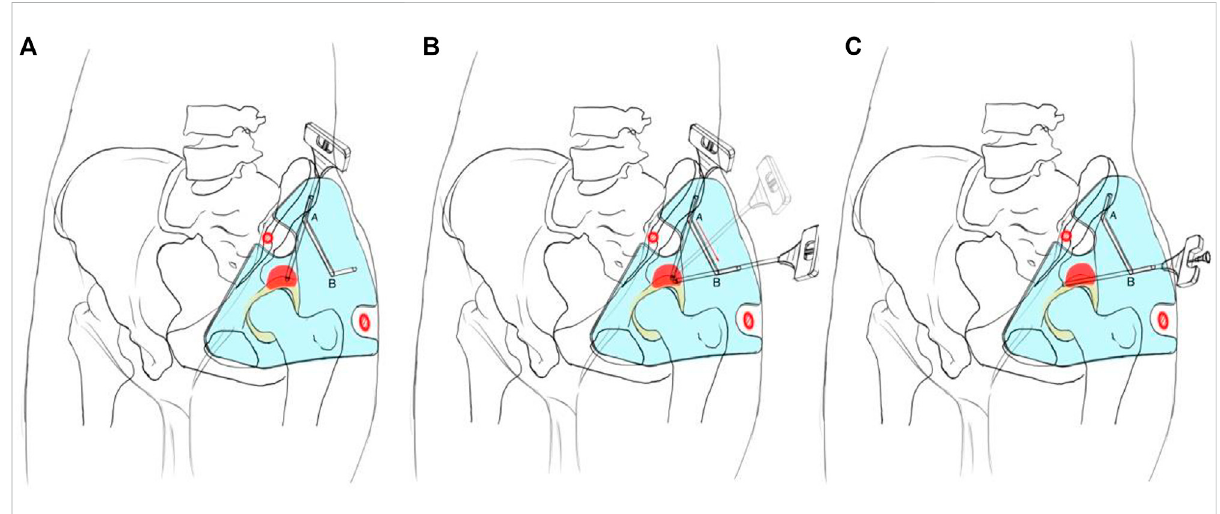
FIGURE 2 Operation procedure of the 3D printing individualized guide